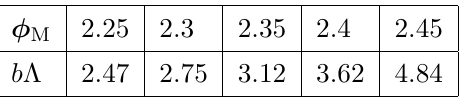
Figure 7 . Longitudinal profiles of an interface with (left) φ M = 2 . 35 and initial energy density E 3 ; (right) φ M = 2 . 45 and initial energy density E 1 both for a single plateau in continuous black with initial energy density E 3 and the fitted interface shape in dashed green.